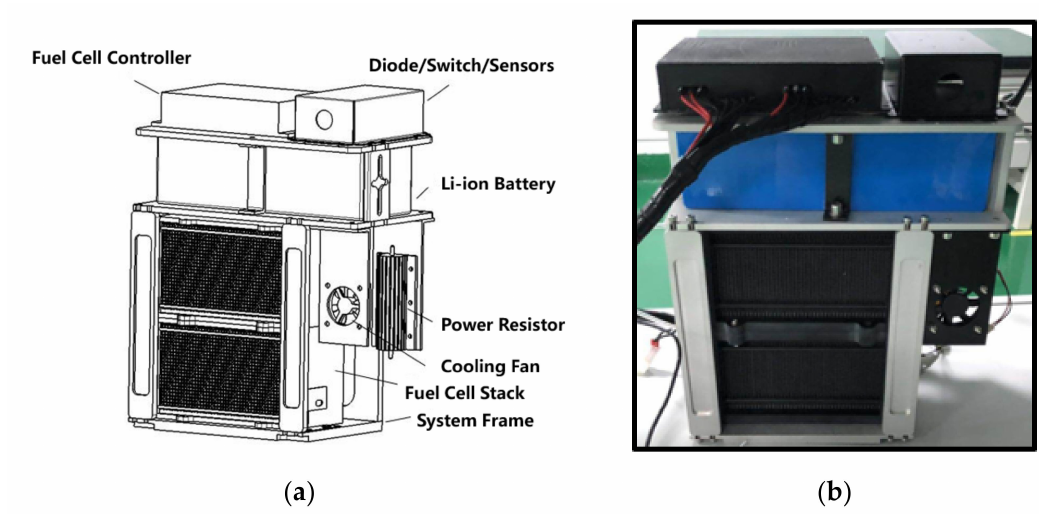
Figure 7. Practical design of passive fuel cell/Li-ion battery hybrid system for an e-scooter: ( a ) Structural design; ( b ) Practical module.